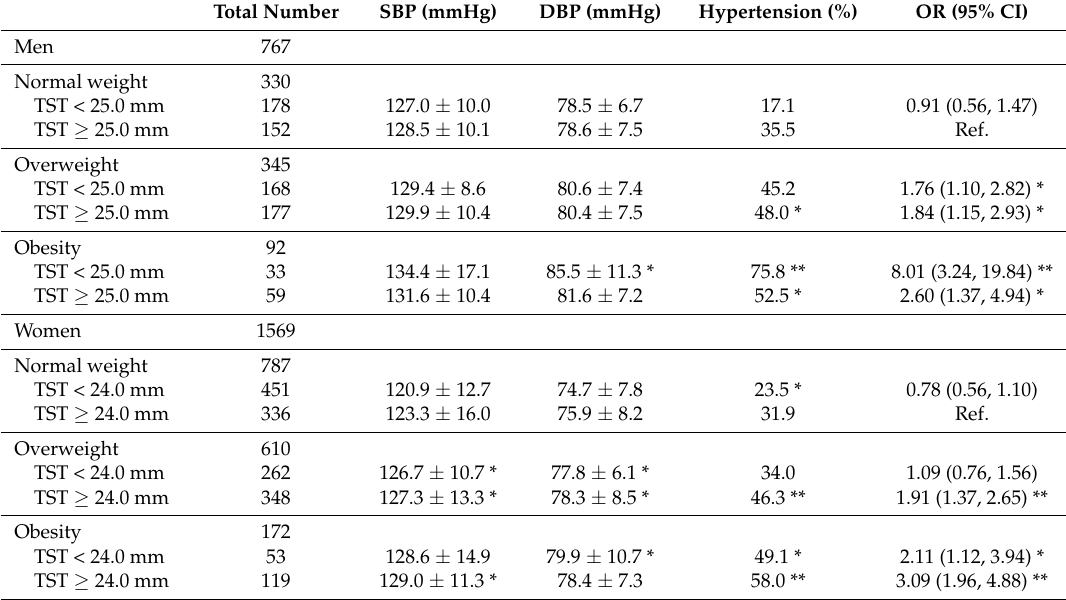
The mean and standard deviation of blood pressure were estimated using participants without anti-hypertensive medication; overweight was defined as body mass index ≥ 24 kg/m 2 and <28 kg/m 2 ; obesity was defined as